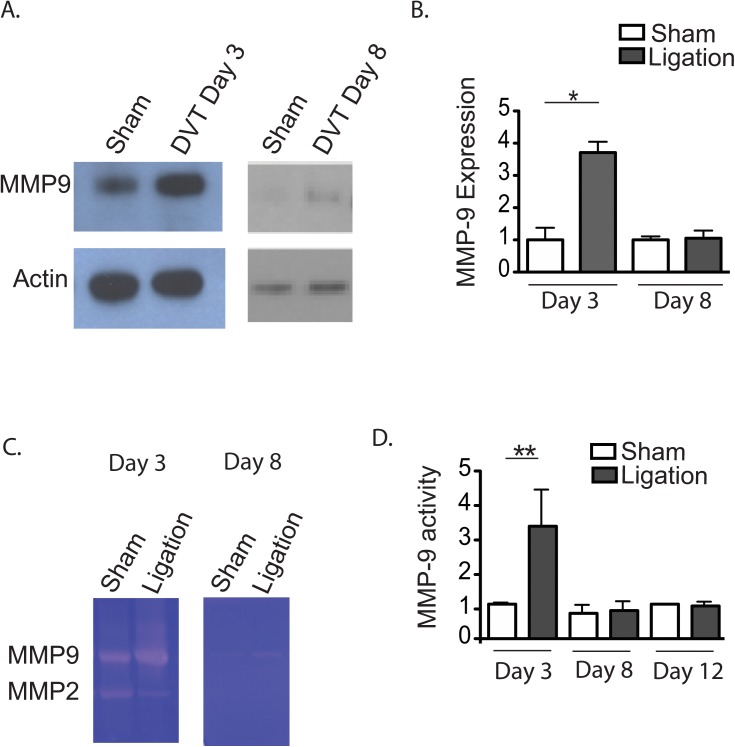
Expression and enzyme activity of MMP-9 are increased during thrombus resolution.MMP-9 expression by immunoblot analysis of combined thrombus and vein wall samples at day 3 and day 8 (A) and over time by densitometry analysis (B) in sham and ligation (DVT) groups. MMP-9 activity by zymography in combined thrombus and vein wall samples at day 3 and day 8 (C) and over time by densitometry analysis (D). Differential expression (E) and activity (F) of MMP-9 in vein wall (VW) versus thrombus (Th) at indicated time points. MMP-2 also indicated on zymogram (F). (*,**p<0.05)